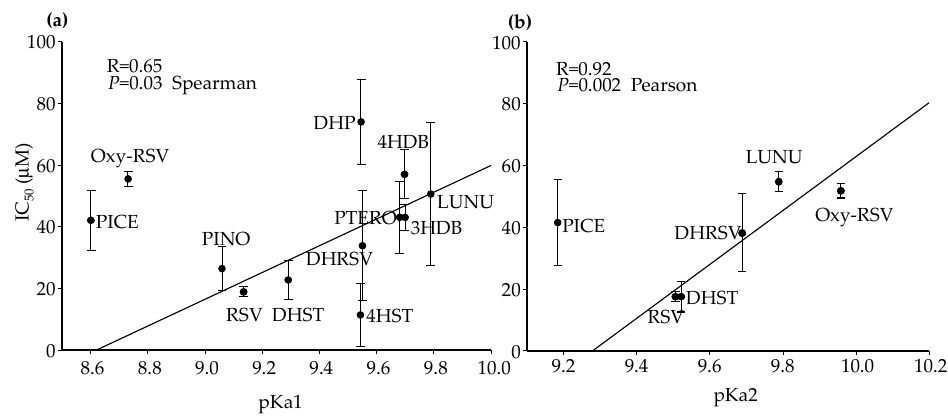
Figure 7. IC 50 values dependence on pKa1 ( a ) and pKa2 ( b ) in Caco-2 cells after 72 h. Spearman and Pearson correlation values were calculated excluding PICE and Oxy-RSV ( a ) and PICE ( b ). Values are shown as mean ± SD (n = 3).